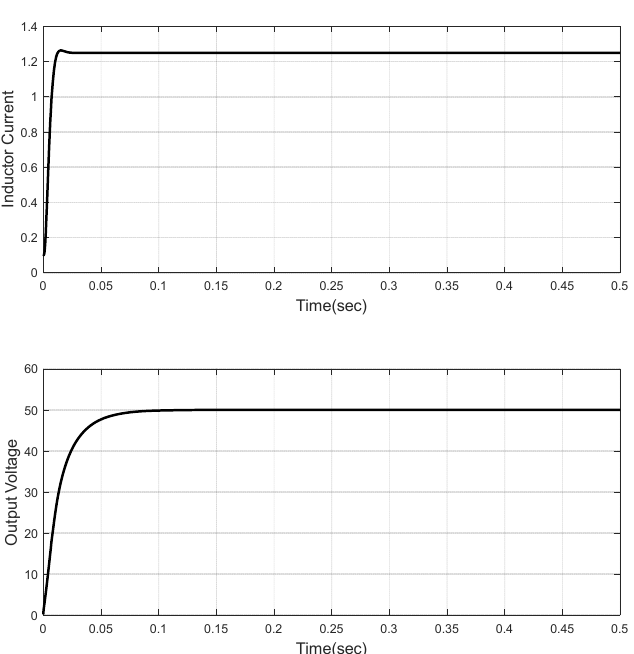
Figure 20. The behaviour of the inductor current and output voltage in the presence of measurement noise.